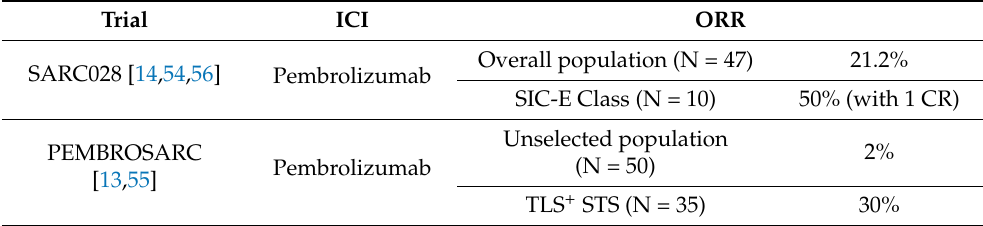
Figure 2. Composition of a tertiary lymphoid structure. Table 2. Responses to checkpoint inhibitors in SIC-E and TLS + STS.